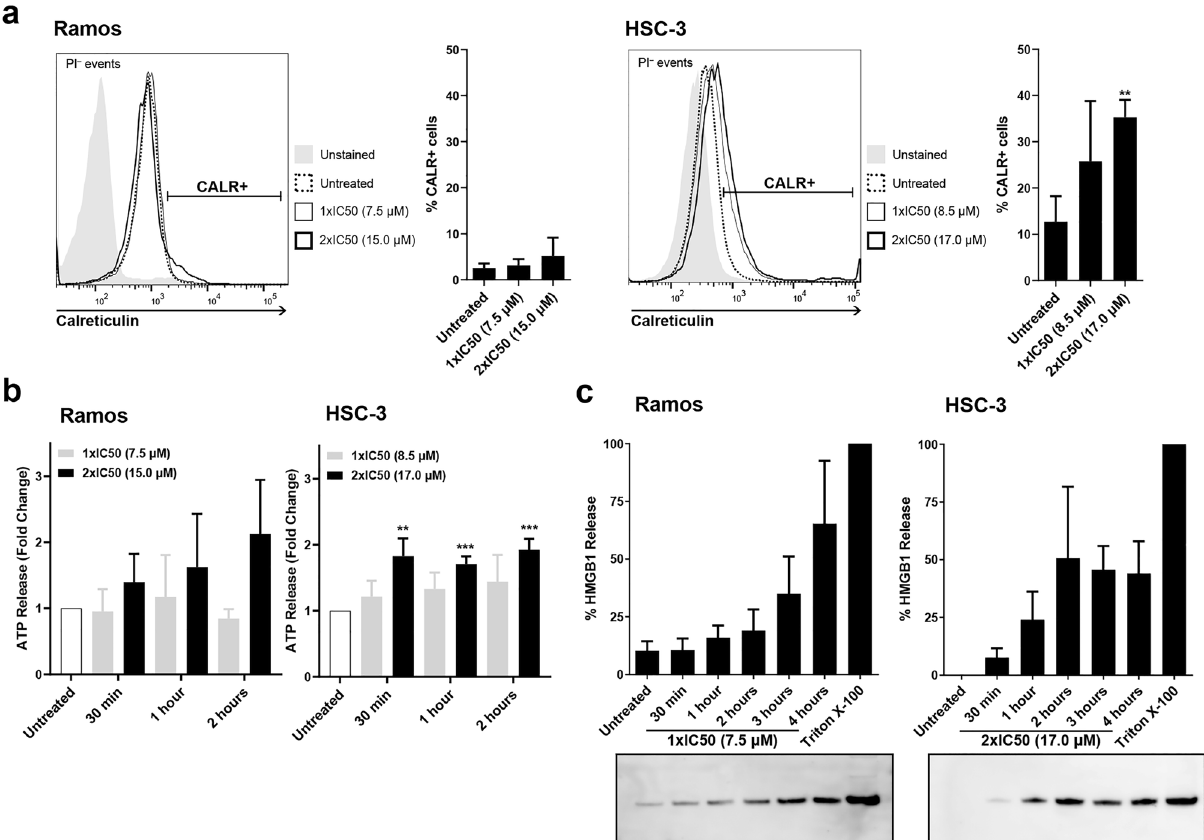
Figure 6. MPM-1 induces the release and exposure of DAMPs related to immunogenic cell death. ( a ) Cell surface exposure of calreticulin by Ramos and HSC-3 cells treated with 1xIC50 or 2xIC50 MPM-1 for four hours was assessed by flow cytometry. Calreticulin expressing cells were identified among live (PI negative) cells. The bar graph shows the mean percentage of calreticulin expressing cells from three separate experiments with error bars denoting the standard deviation. Significant differences between treated and untreated groups were determined by unequal variances t-test. ( b ) Release of ATP from Ramos and HSC-3 cells treated with MPM-1 was assessed by a firefly luminescence assay. Bars represent the mean ATP release from five individual experiments, expressed as fold increase relative to untreated (control) cells. Significant differences between treated and untreated groups were determined by repeated measures ANOVA and Dunnett’s post-hoc. ( c ) Release of high mobility group box 1 (HMGB1) from cells treated with MPM-1 was assessed by Western blotting. Untreated and Triton X-100 treated cells served as negative and positive control, respectively. Bars represent the mean from three independent experiments with error bars denoting the standard deviation. The blots have been cropped for presentation in this figure. Original blots are presented in Supplementary Fig.